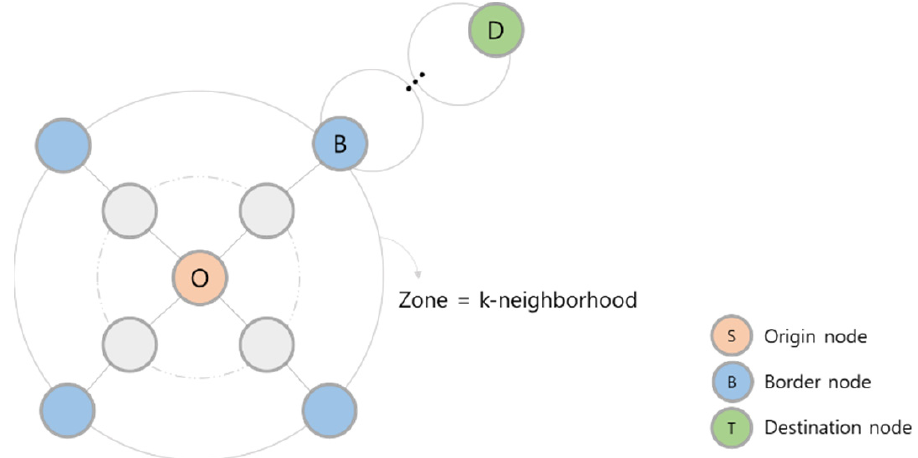
Figure 1. Transaction Spreading using Zone Routing.